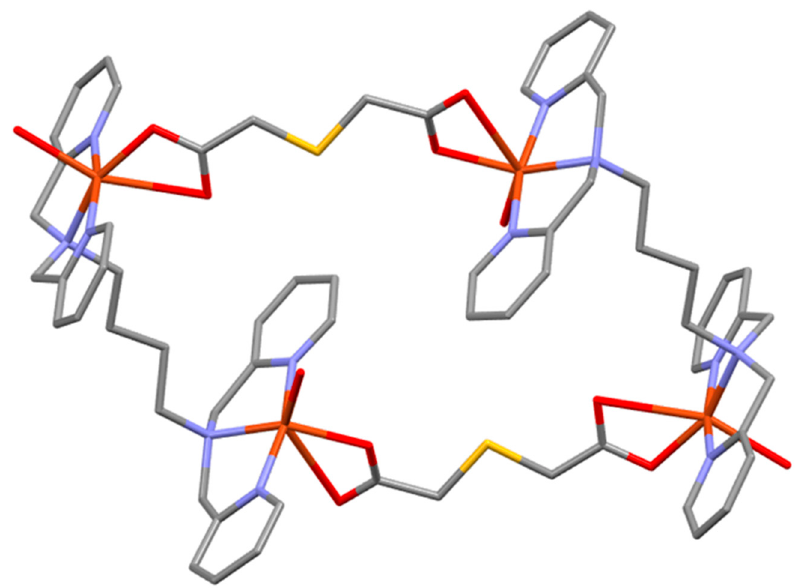
Figure 1. Molecular rectangle structure of the complex [Cu 4 (tpbn) 2 (tda) 2 (H 2 O) 4 ](ClO 4 ) 4 . (Cu, N, O,